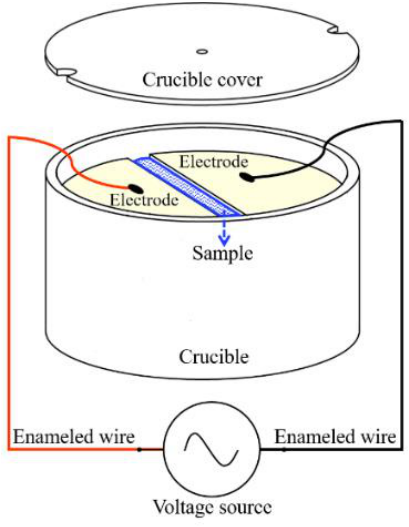
Figure 1. DSC sample crucible with microelectrodes.